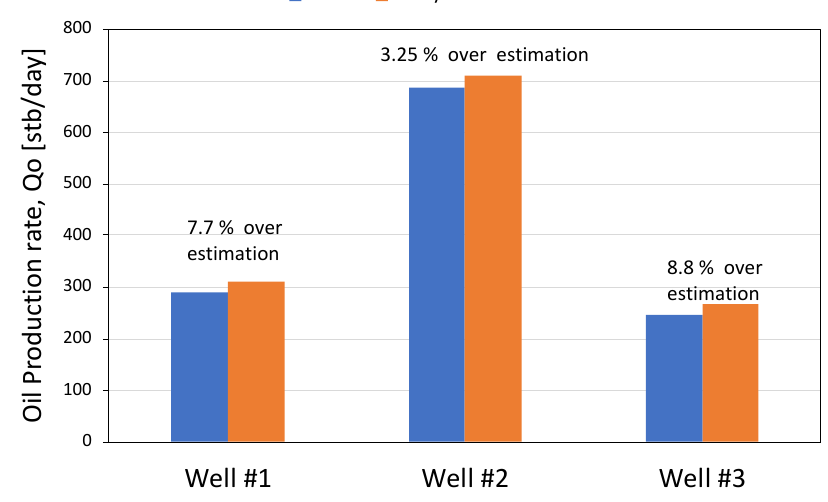
Figure 6. Comparison of oil production rate from three radial-lateral wells in Belayim Land Oil Field with model estimated production rate.